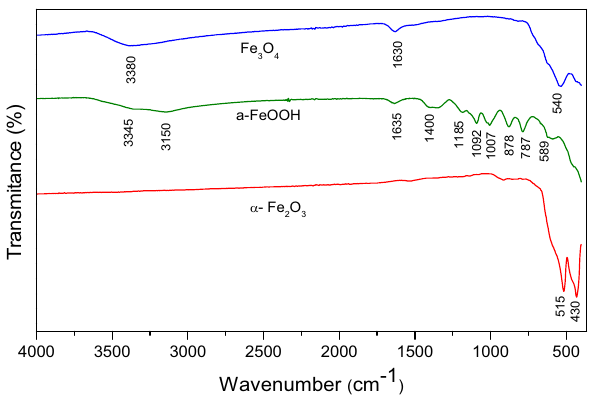
Figure 3: FTIR spectra of hematite, magnetite, and amorphous oxide, a - FeOOH.